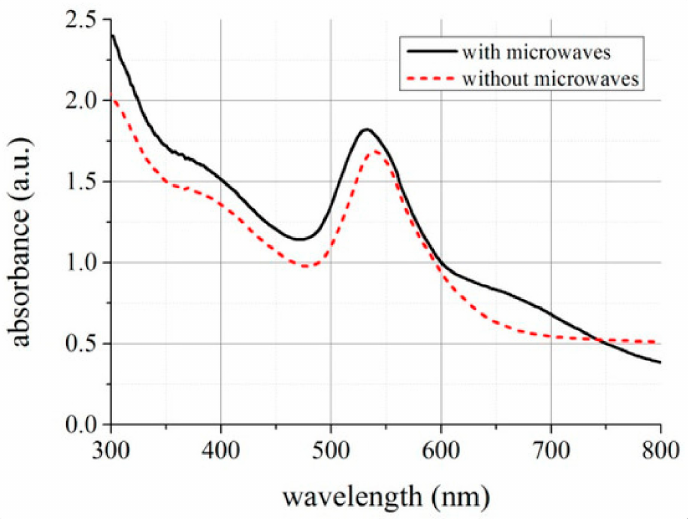
Figure 23. The UV–Vis spectra for the reaction mixture with and without microwaves in the microre- actor